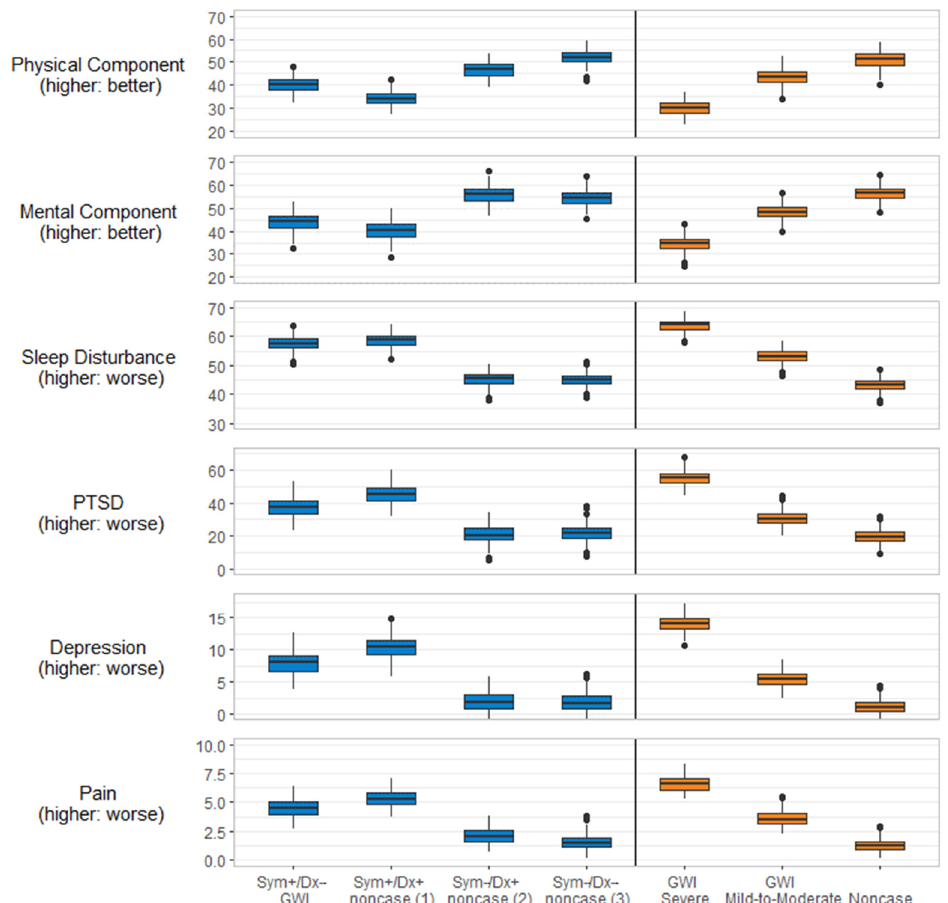
Figure 1. Adjusted boxplots of Health-related Quality of Life measures by Gulf War illness case status. Note: Model adjusted for age (continuous), sex, race/ethnicity, education, income, deployment status, military component, and military branch (see Tables S4 and S5 for regression coefficients). Mean differences were compared across categories within the Kansas definition and alternatively across categories within the CDC definition. Comparisons were made to GWI for Kansas and for CDC GWI severe for CDC GWI categories. All differences were statistically significant ( p < 0.001); sleep disturbance total score did not differ between KS GWI: Sym+/Dx − and KS noncase (1) Sym+/Dx+. GWI = Gulf War illness; PTSD = post-traumatic stress disorder; Sym = symptom criteria; Dx = Diagnoses.